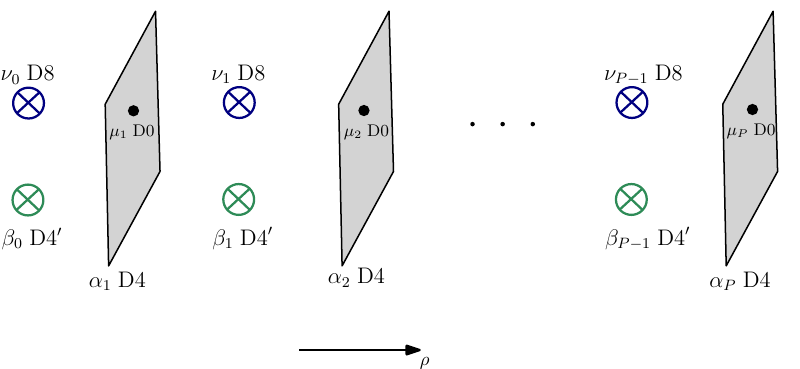
Figure 5 . Hanany-Witten like brane set-up associated to the quantised charges of the solutions.